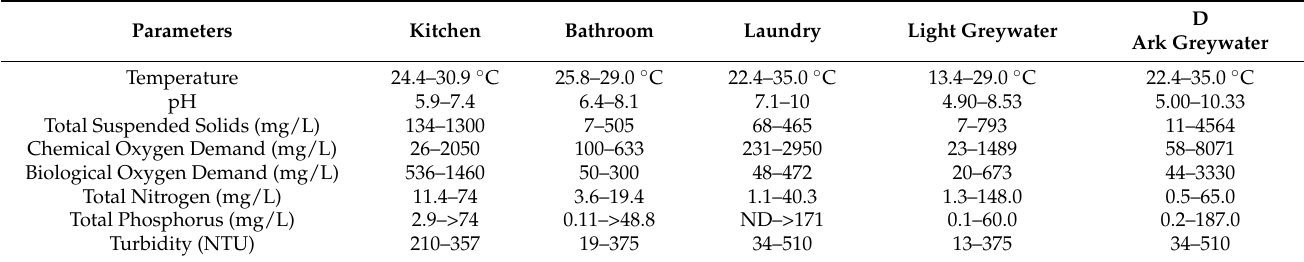
Table 2. Physicochemical properties of